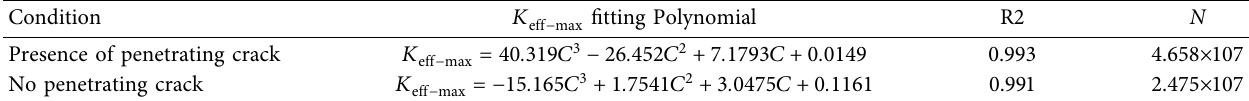
Table 3: Keff-max fitting polynomial and fracture